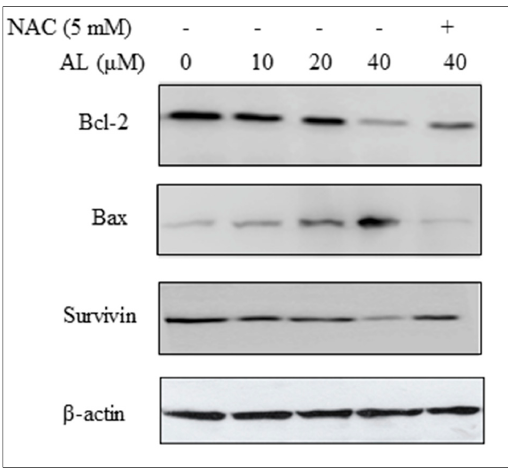
Figure 6. Western blot analyses of STAT3 downstream target genes and pro-apoptotic Bax protein. DU145 cells were treated with altholactone (10, 20 and 40 µ M), and then harvested for western blotting. Equal amounts of lysate protein were subjected to gel electrophoresis. β -Actin was used as loading control. Data are representative of three independent experiments with similar